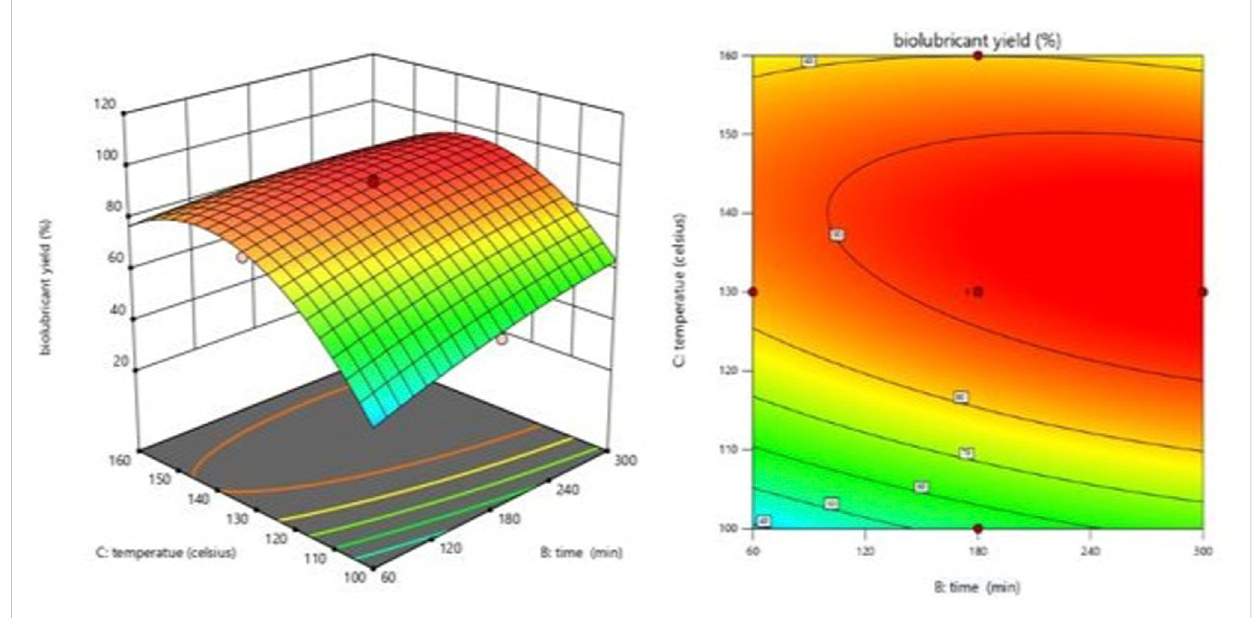
FIGURE 7 Effect of the interaction of temperature and time on biolubricant yield.